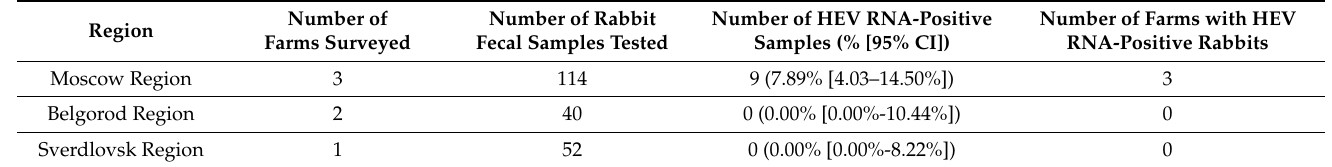
Table 4. Rates of HEV excretion in farm rabbits aged 2–10